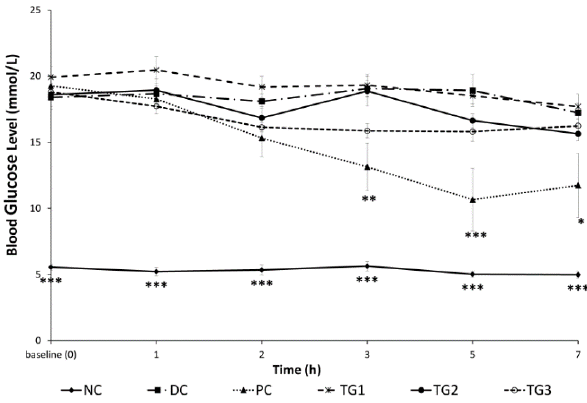
Figure 2. Acute (single) treatment with Gongronema latifolium extract in STZ-induced diabetic rats ( n =